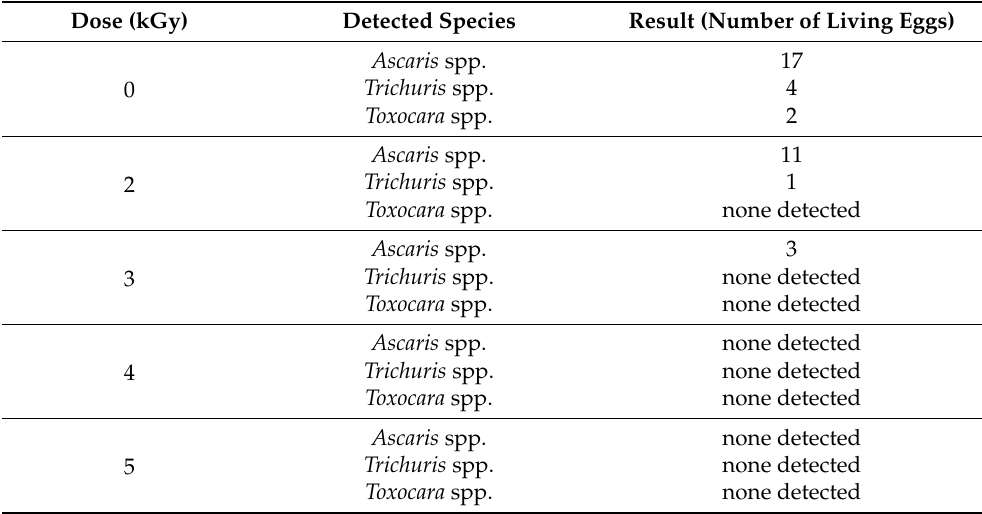
Table 5. Results of the analysis for the presence of living eggs of helminths: Toxocara spp., Trichuris spp. and Ascaris spp. in postflotation sludge from WWTP 1.